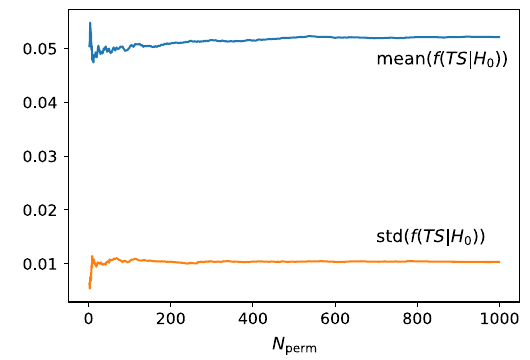
Fig. 5 Effectof N perm onthenull-hypothesisteststatisticforthemono- jet study with T 2 events are divided between B and T ; It is only necessary to specify N B and N T at this